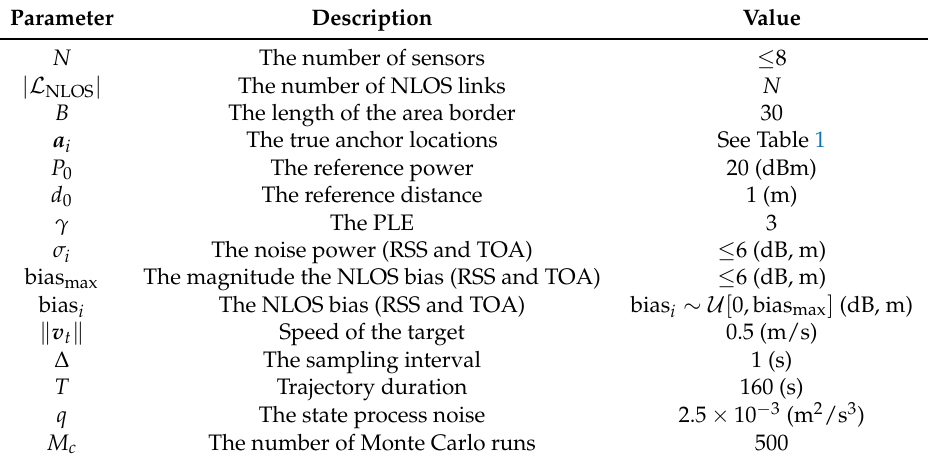
Table 2. Summary of the simulation parameters.